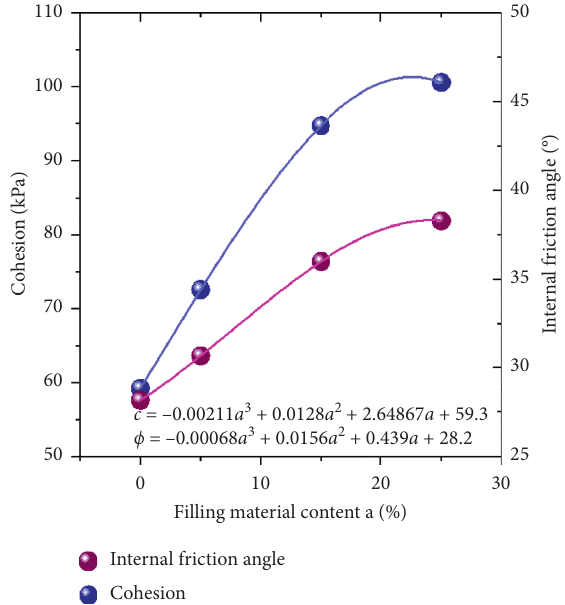
Figure 15: Filling material content against cohesion and internal friction angle from